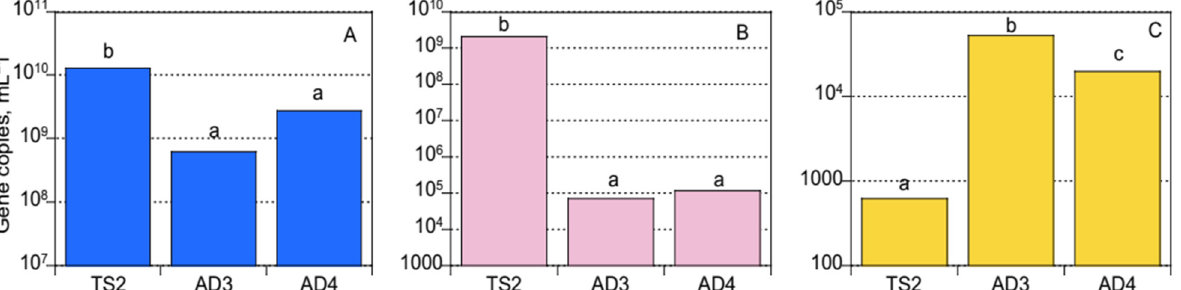
Figure 4. Quantification of target genes in TS2, AD3, and AD4 consortia: ( A ) 16S rRNA of Bacteria, ( B ) 23S rRNA of Klebsiella sp., and ( C ) hydrogenase hydA of Clostridium spp. Different lowercase letters indicate significantly different results (ANOVA, p < 0.05).